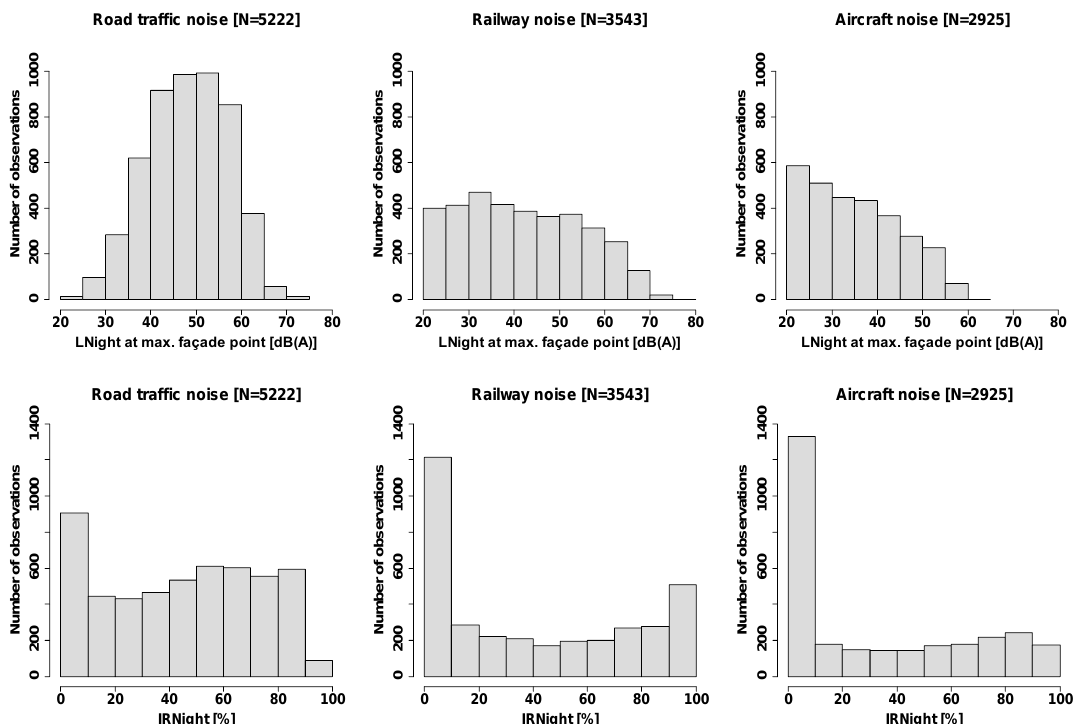
Figure 1. Frequency distribution of the LNight (top) and IRNight (bottom) among all valid cases. IRNight (bottom) is calculated at the corresponding façade point with the maximum LNight exposure for each respondent.